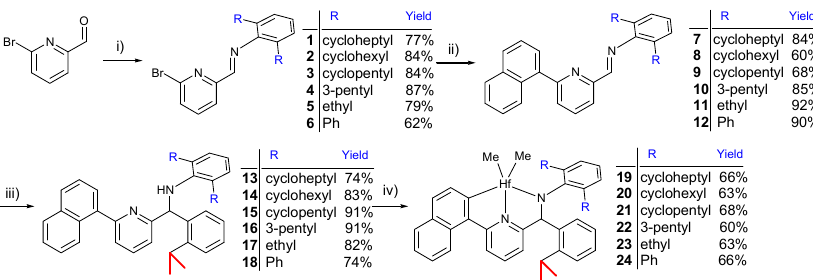
Scheme 2. The synthesis of aniline compounds.